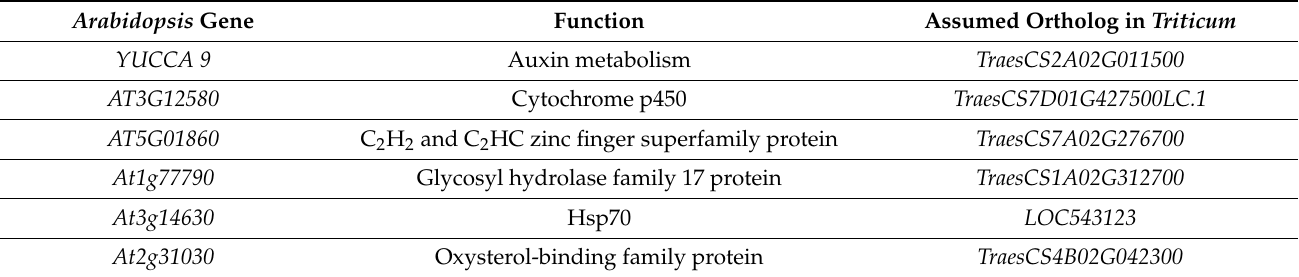
Table 1. The genes and their orthologs studied in Triticum